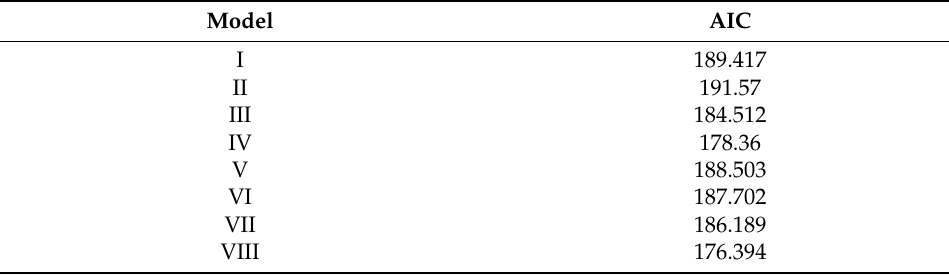
Table 7. Akaike information criteria for applied statistical